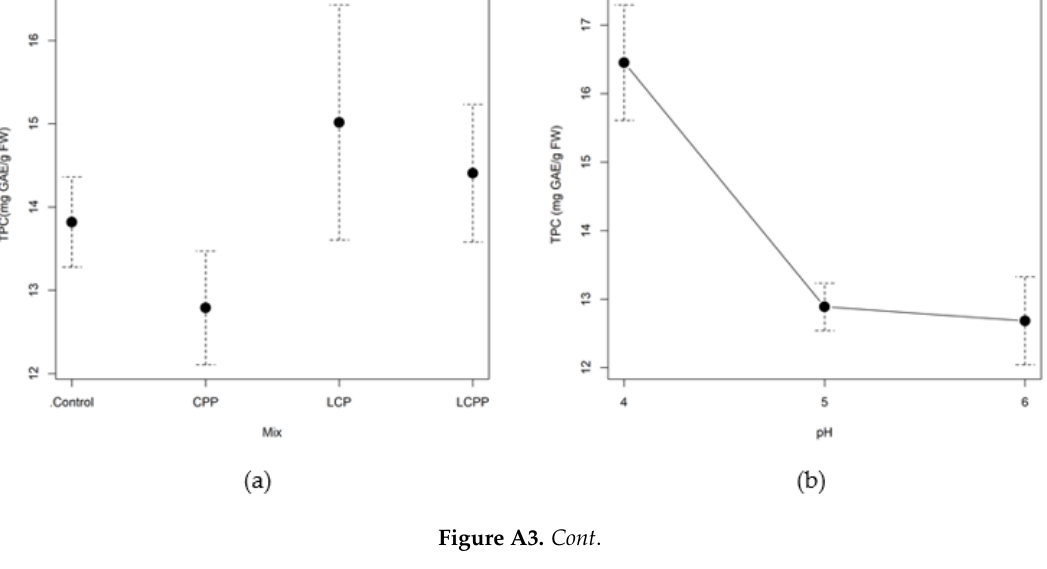
Figure A3. The total phenolic content (TPC; mg GAE/g FW) in ethanolic extracts plotted as a function of the ( a ) enzymatic mix with laccase, cellulose, and pectinase at proportions of 1:1:1 (LCP), 1:1:2 (LCPP), and 0:1:2 (CPP), ( b ) pH (4 – 6), ( c ) temperature (30 – 50 °C), and d) time (0.5 – 2.5 h).